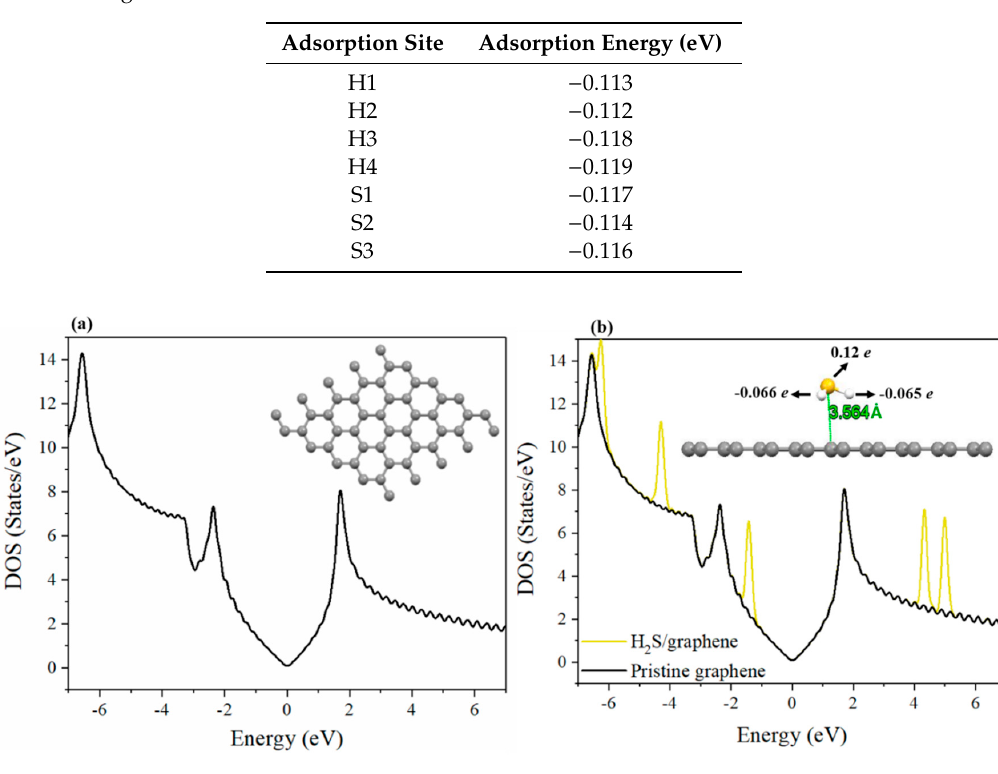
Figure 5. DOS plots for pristine graphene sheet: ( a ) before and ( b ) after adsorption of the H 2 S molecule at site H4 (the Fermi level is set to zero).